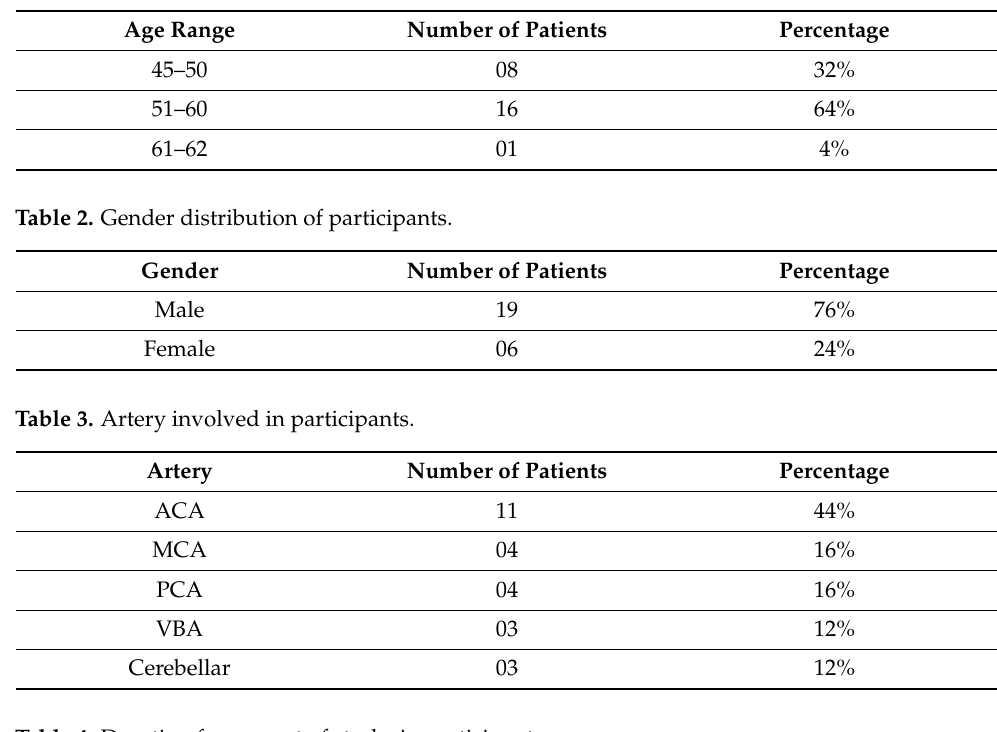
Table 4. Duration from onset of stroke in